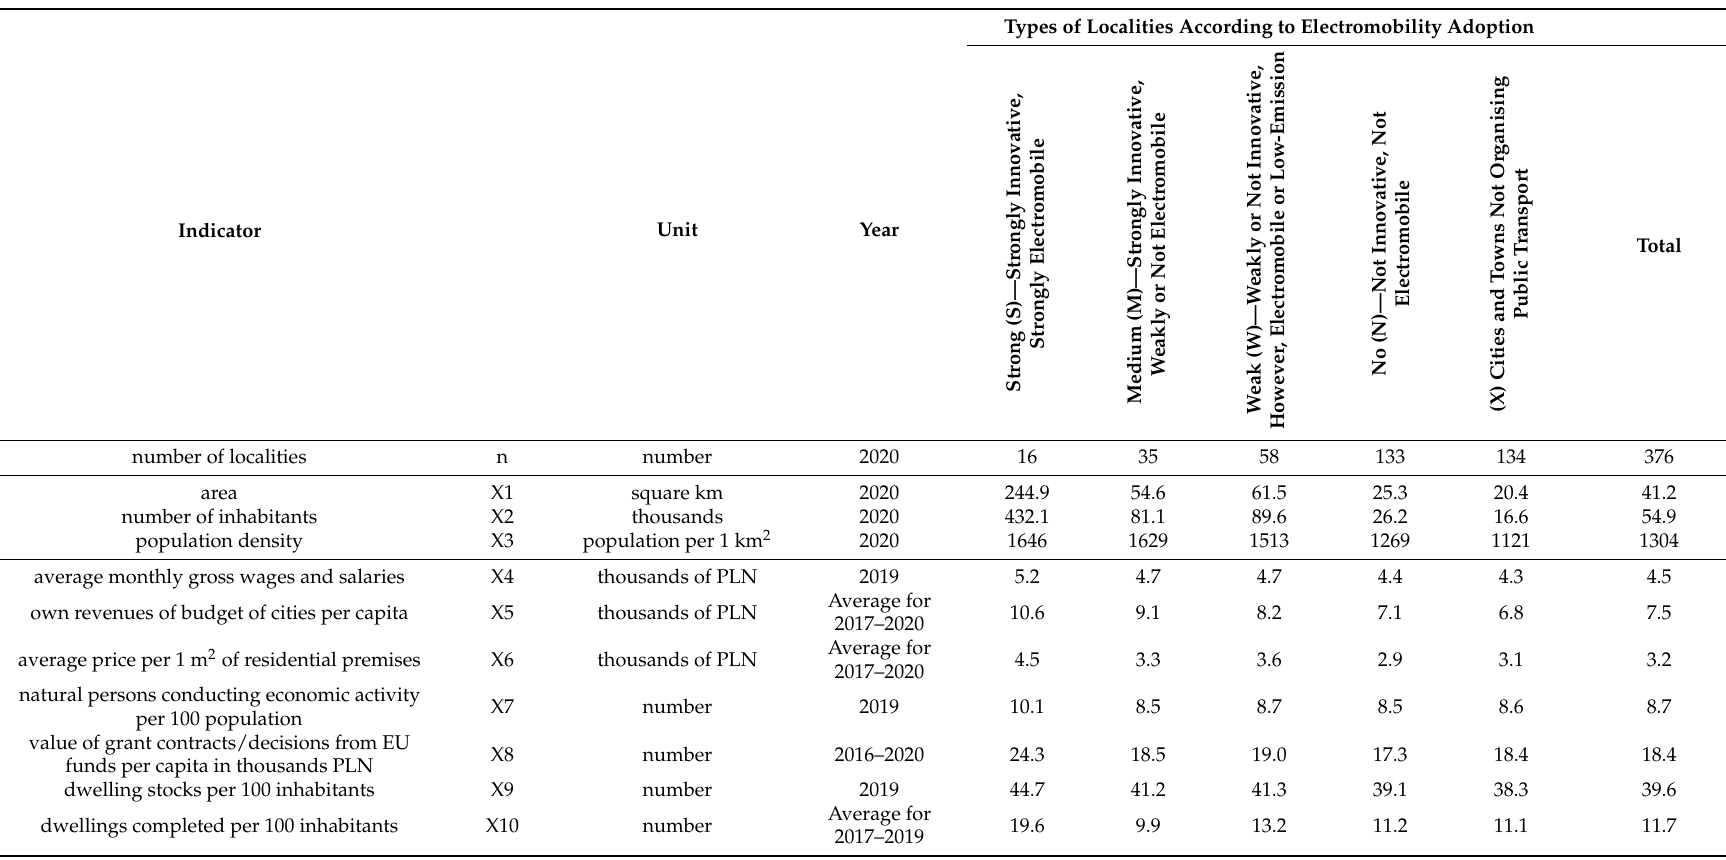
Table 9. Socio-economic characteristics of electromobility-adoption city types (comparison of the means method). Types of Localities According to Electromobility